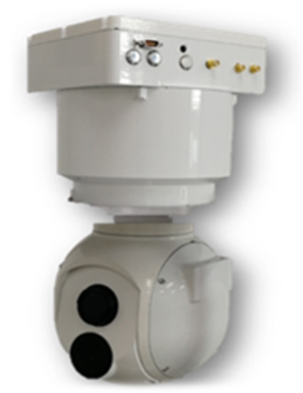
Figure 6. The physical diagram of the system.